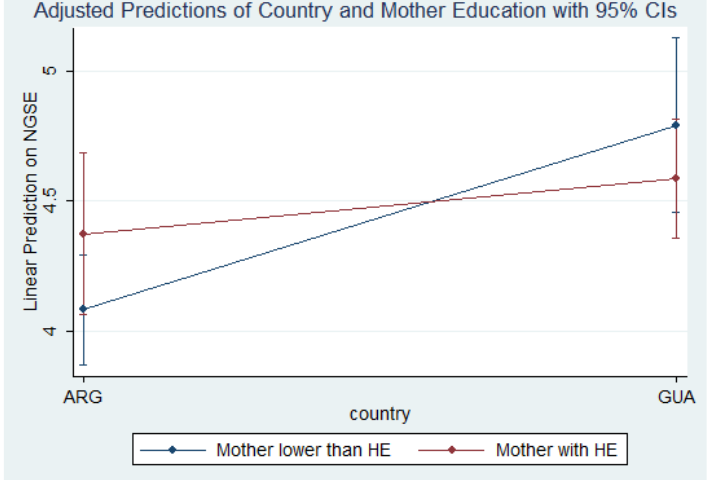
Figure 2. Self-efficacy differences in country and mother’s higher educational level (HE). Note: the figure refers to values at 95% confidence level (CI). In the ordinate axis the predicted value of the New General Self-Efficacy scale (NGSE). Referring to the countries ARG is Argentina and GUA is Guatemala.